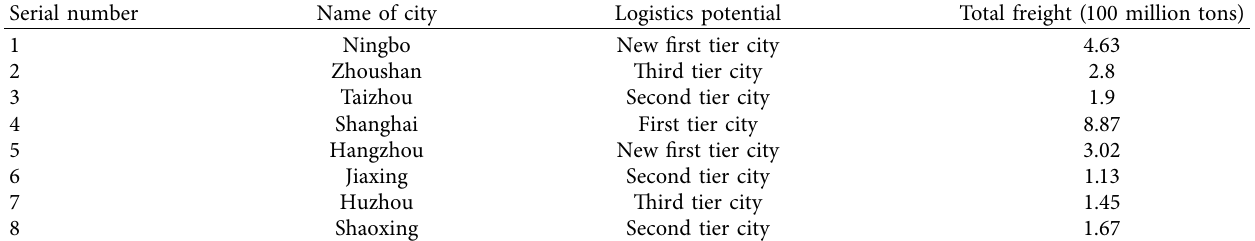
Table 2: Intra-cluster logistics volume of each city.